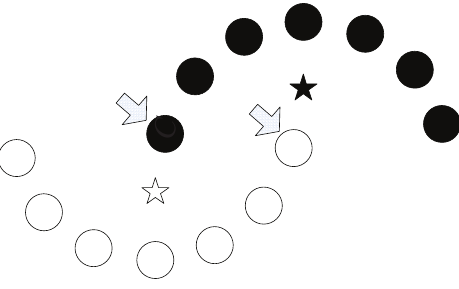
Figure 1. Illustration of problem in the centroid-based clustering method.